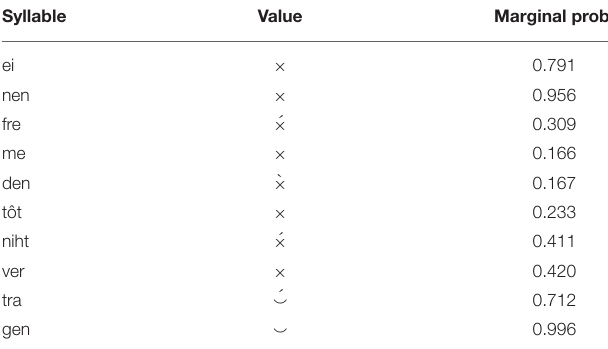
TABLE 11 | Example (11), average probability 0.516.